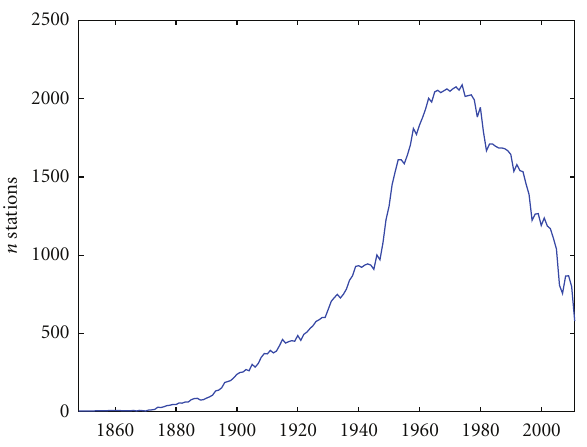
Figure 2: GHCN-Daily stations with annual minimum tempera- ture data per